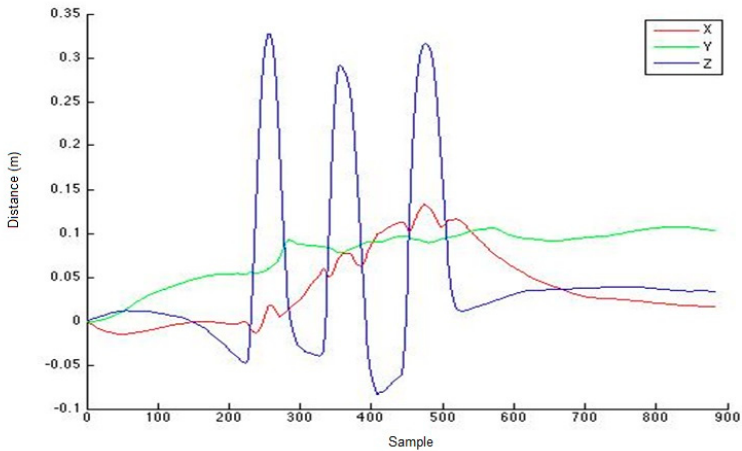
Figure 4. The 3D positioning data obtained by the IMU with the Madgwick filter.